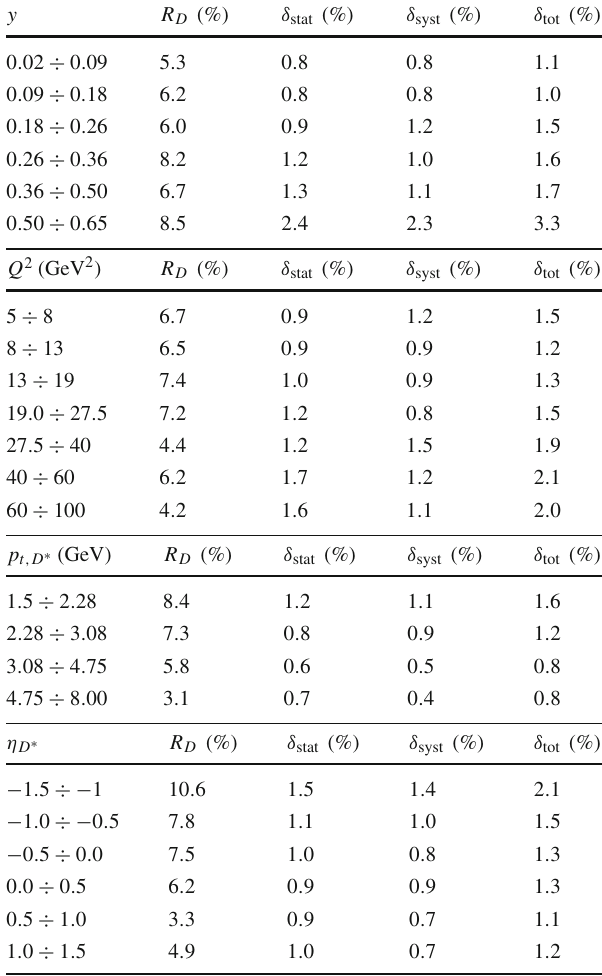
Table 3 The values of diffractive fraction for D ∗ production cross sec- tions together with statistical ( δ stat ), systematic ( δ syst ) and total uncer- tainties ( δ tot ) as a function of y , Q 2 , p t , D ∗ and η D ∗ . The total uncertain- ties are obtained as the statistical and systematic uncertainties added in